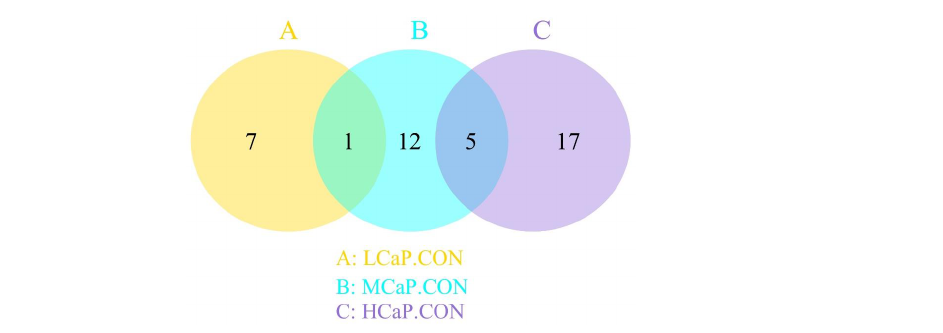
Figure 4. Venn diagrams of differential metabolites for pairwise comparison between the CON group and the LCaP, MCaP, and HCaP groups. CON: control group, without calcium propionate addition; LCaP: low calcium propionate, the calcium propionate addition level was 200 g/d per cow; MCaP: medium calcium propionate, the calcium propionate addition level was 350 g/d per cow; HCaP: high calcium propionate, the calcium propionate addition level was 500 g/d per cow. 2.5. Metabolic Pathways Enrichment of Differential Metabolites The metabolic pathways were analyzed based on the identified differential metabolites and their expression levels between the different treatment groups (Figure 5). The pathway of vitamin B6 metabolism ( p = 0.079, impact value = 0.036) was enriched from the differential metabolites between the LCaP and CON groups. The pathways of pantothenate and CoA biosynthesis ( p = 0.009, impact value = 0.071), beta-alanine metabolism ( p = 0.011, impact value = 0.063), morphine addiction ( p = 0.041, impact value = 0.125), and the cGMP-PKG signaling pathway ( p = 0.051, impact value = 0.100) were mainly enriched from the differential metabolites between MCaP and CON groups. The differential metabolites between the HCaP and CON groups were mainly enriched in the AMPK signaling pathway ( p = 0.011, impact value = 0.091) and pyrimidine metabolism pathway ( p = 0.085, impact value = 0.031). The differential metabolites between the HCaP and MCaP groups were mainly enriched in the cGMP-PKG signaling pathway ( p = 0.001, impact value = 0.200).